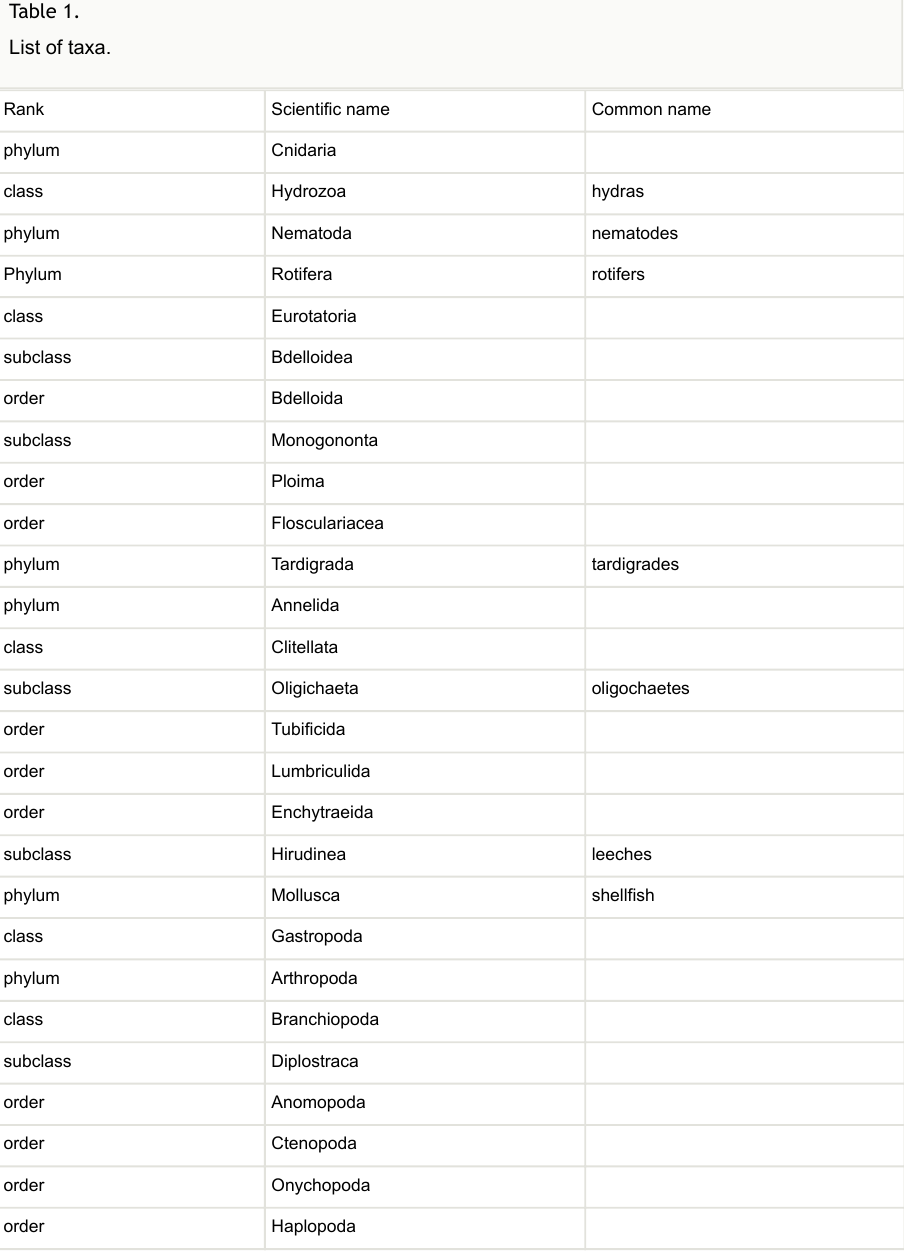
occurrences are included in the resource. In the dataset, full taxonomic affiliation is given for each record, including: Type, Class, Subclass, Order, Family, Subfamily, Genus, Subgenus, Species, lifestage, individuals per sample (for zoobenthos) and individuals per m (for zooplankton). Table 1. List of